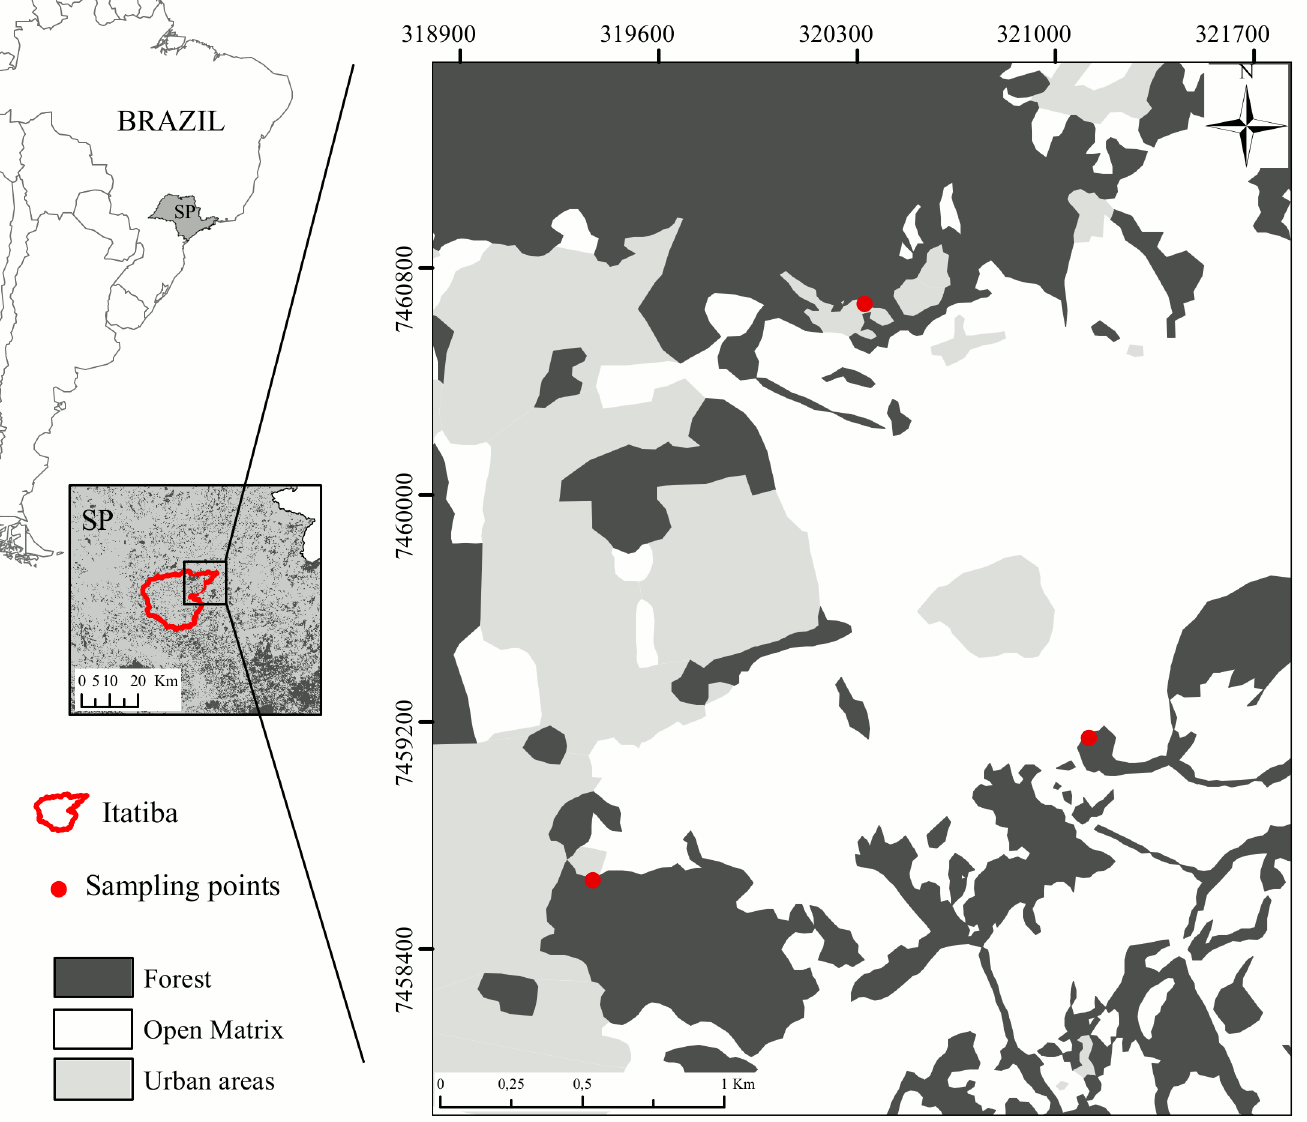
Fig 2. Study area encompasses the city limits of Itatiba, State of S ã o Paulo, southeastern Brazil. The red points correspond to locations where T . rufiventris and T . leucomelas were captured. Land cover composition was: 51.0% pasture, 0.1% crops (mainly Citrus and corn fields), 14.9% urban areas, 1.1% water, 23.4% forest, 9.5% old plantations of Eucalyptus embedded in forested areas. Live fences are formed by lines of native trees, such as Casearia sylvestris , Lithraea mollioides and Erythroxyllum deciduum , located on different